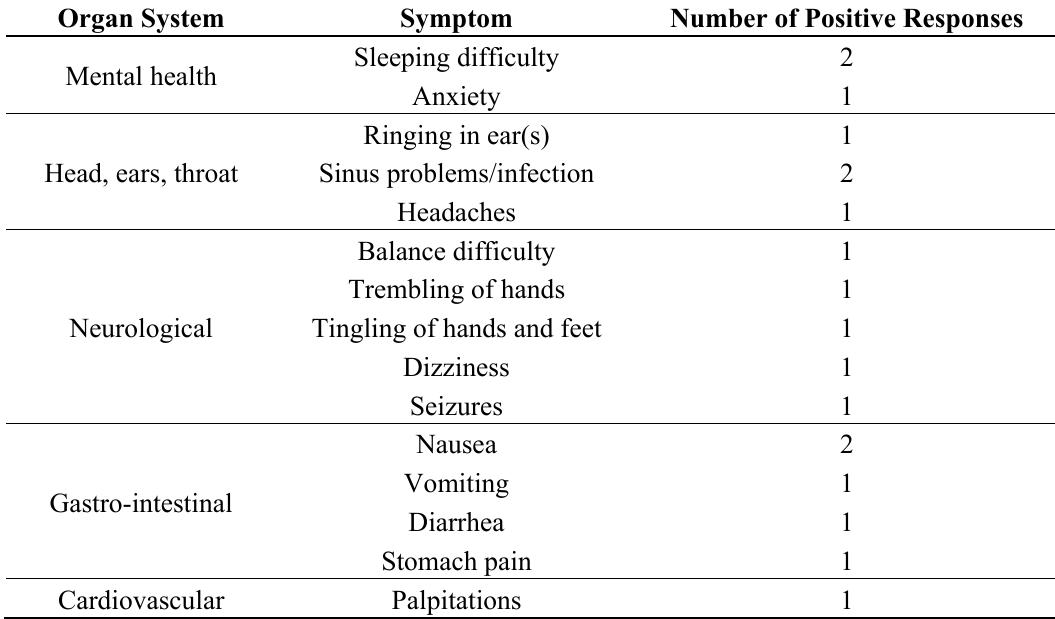
Table 3. Symptoms Attributed by Participants to UNGD ( n =